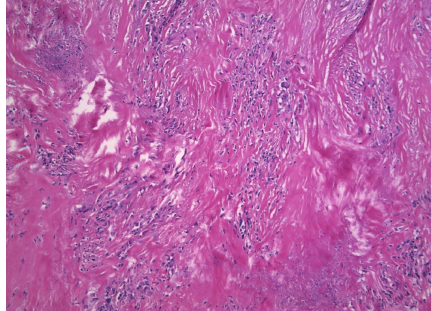
Figure 5: Hematoxylin-Eosin staining. A histological sample from the second operation is shown. Cells are less represented and not well ordered as in Figure 4. There are many acellular